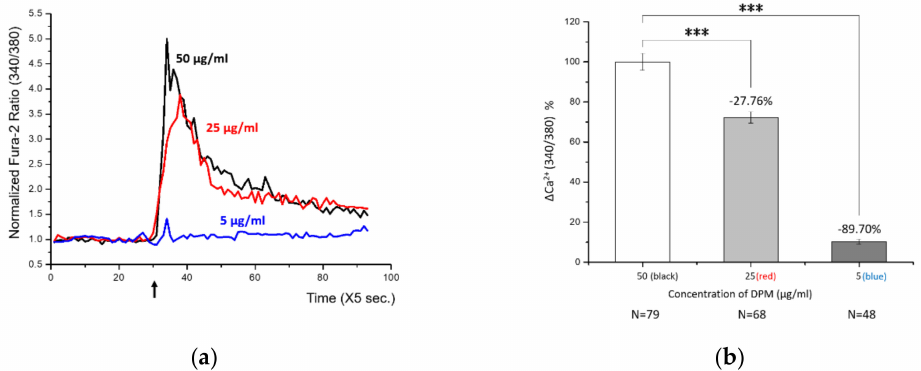
Figure 1. Diesel particle matter (DPM) induced transient Ca 2+ influx in human bronchial/tracheal smooth muscle (HBT-SM) cells. ( a ) HBT-SM cells were treated with different concentrations of DPM at the indicated time (arrow), and intracellular calcium (Ca 2+ ) concentration was monitored. Black, 50 µ g/mL; red, 25 µ g/mL; blue, 5 µ g/mL. ( b ) Highly significant Ca 2+ influx by DPM was observed in a concentration-dependent manner. N indicates the number of cells analyzed. (*** p < 0.001).